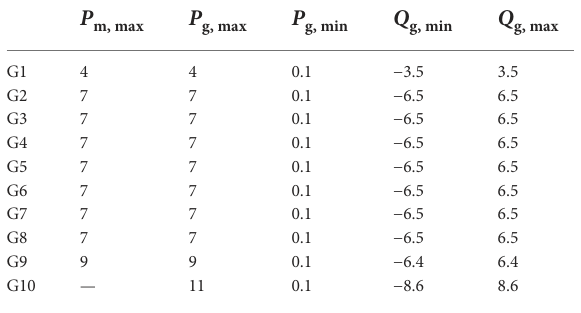
TABLE 4 Technical parameters in per unit for 39-bus system.